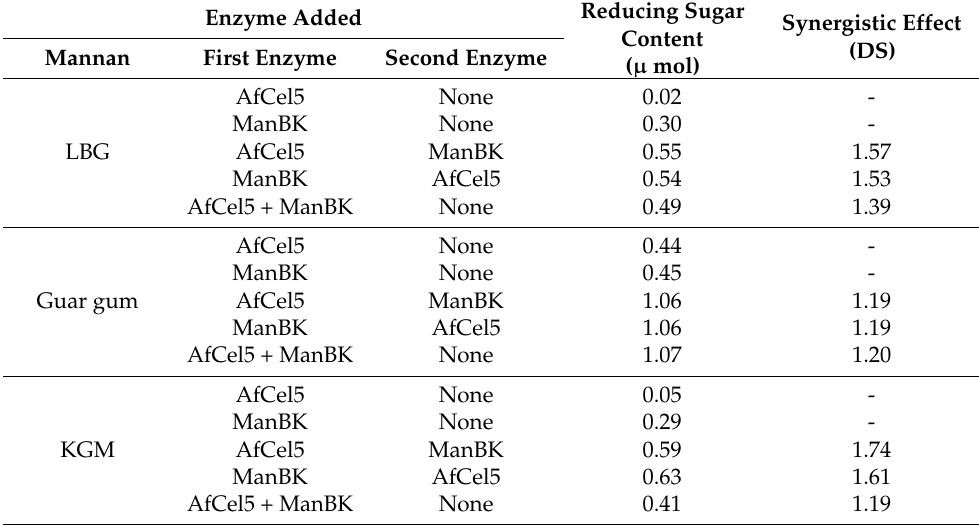
Table 3. The synergistic hydrolysis of AfCel5 and ManBK using mannans as the substrate. Enzyme